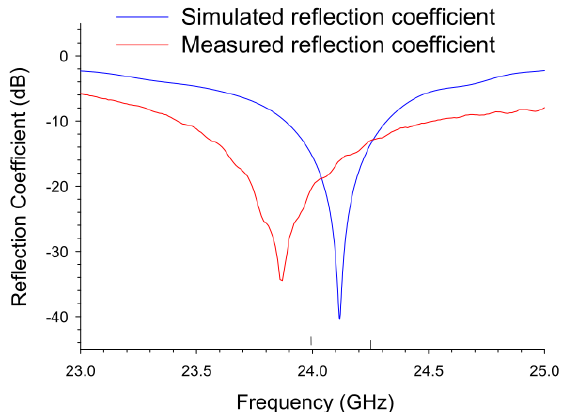
Figure 6. A comparison between simulated and measured reflection coefficients of a representative transmitter